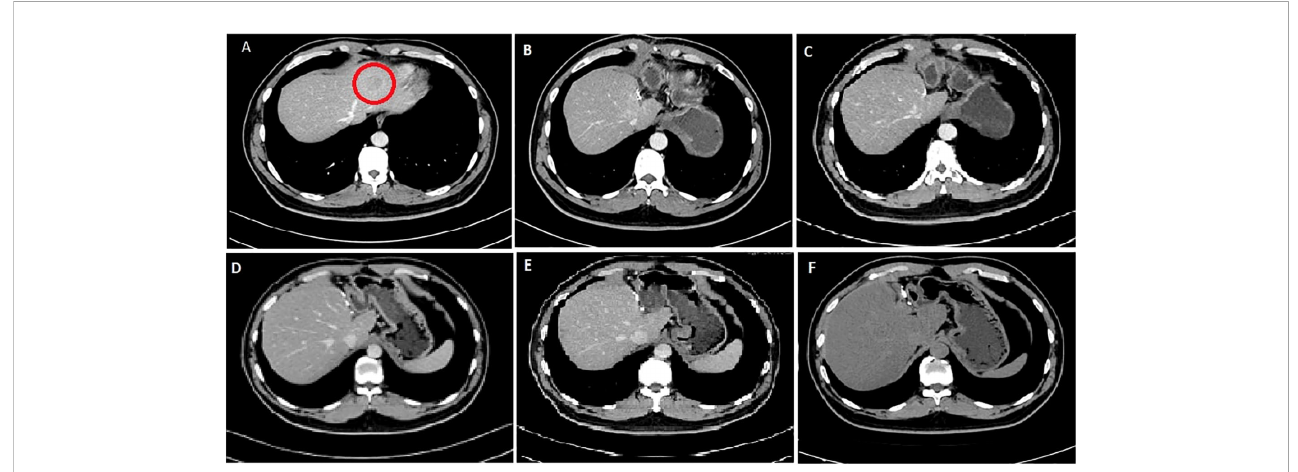
FIGURE 2 CT images of the 41-year-old male patient. (A) First diagnostic CT image showing tumor lesion (red circle) of size 3.0 × 2.8 cm taken in 2015. (B) CT image post-operation and after the fi rst cycle of the GS regimen; no signs of tumor recurrence or metastasis. (C) CT image after the second cycle of the GS regimen. (D) CT image after the fourth cycle of the GS regimen. (E) CT image after the sixth cycle of the GS regimen. (F) CT image taken on follow- up in